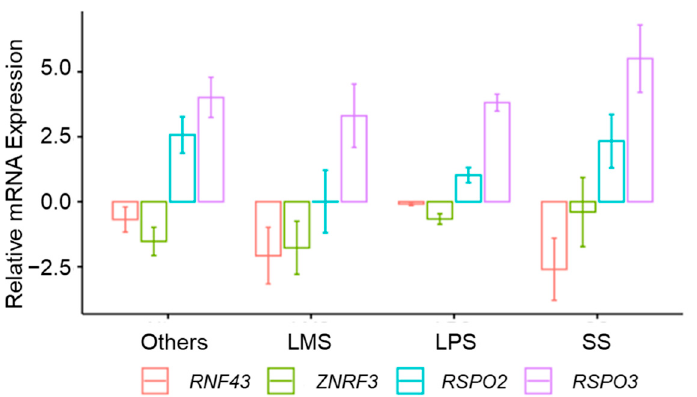
Figure 2. Expression of R-spondin/Lgr5/Rnf43 axis components in tumor samples of STS patients. Values are presented as mRNA expression relative to a pool of RNA of different cell lines (Stratagene QPCR Human Reference Total RNA, 750,500, Agilent Technologies, Santa Clara, California, United States). β -2-microglobulin was used as a reference gene of normalization. Each bar represents the mean ± SEM. Others ( n = 15), LMS: leiomyosarcoma ( n = 6), LPS: liposarcoma ( n = 61) and SS: synovial sarcoma ( n = 4).